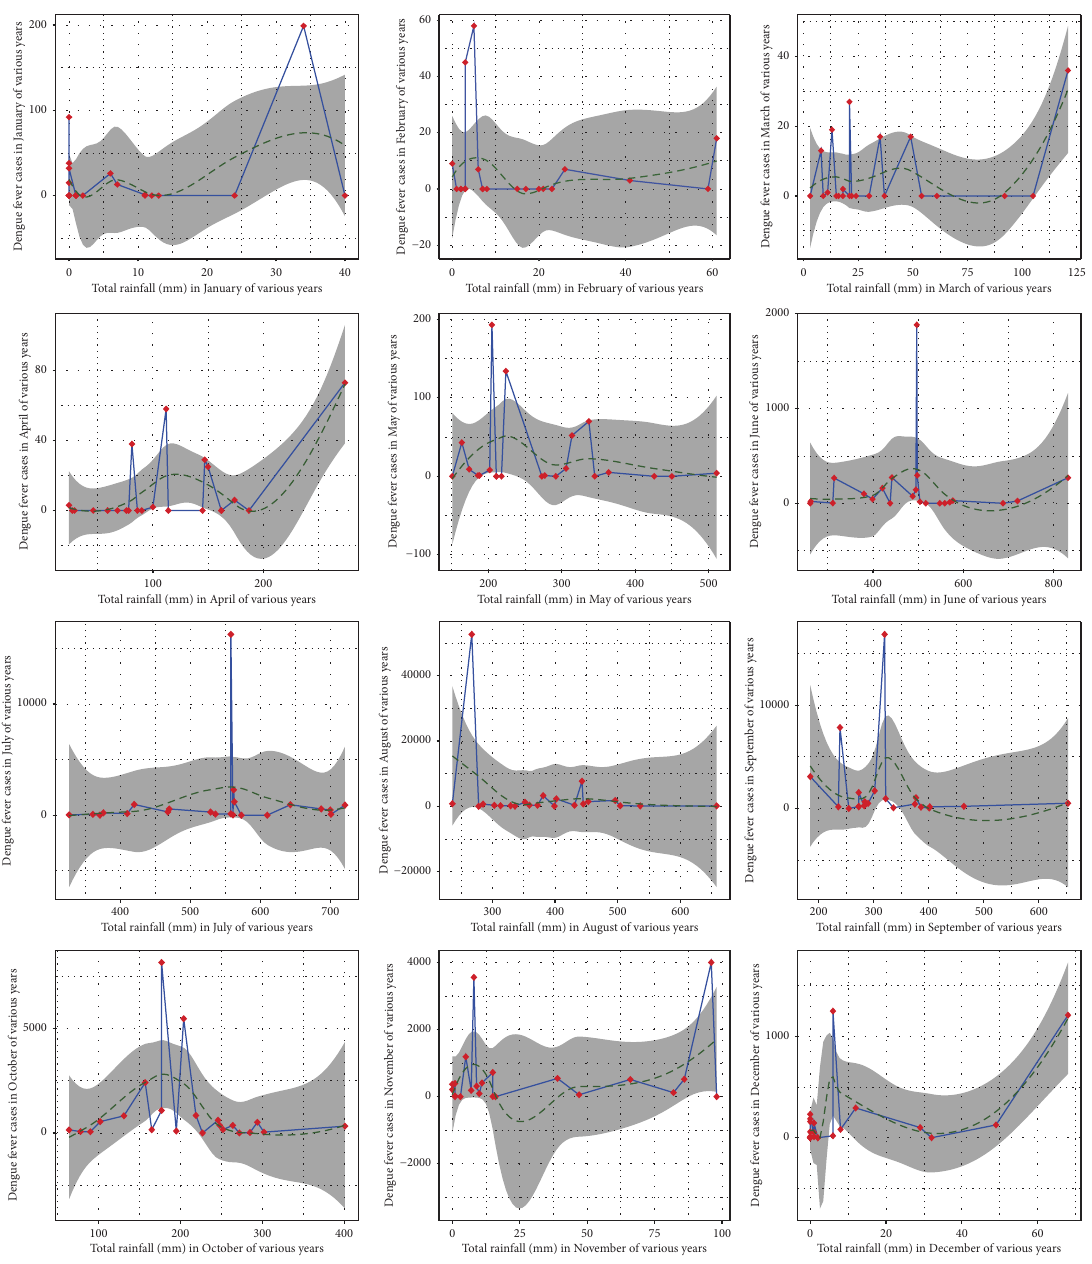
Figure 2: Te impact of monthly total rainfall on monthly dengue cases. Dots represent monthly dengue cases at diferent values of the total rainfall in a particular month in diferent years. A LOESS smoothing function is used to obtain a smooth line to represent the trend of dengue cases at diferent values of the total rainfall in a particular month over the years. Te shaded area denotes the 95% confdence interval of monthly dengue cases at diferent values of total rainfall for a particular month over the